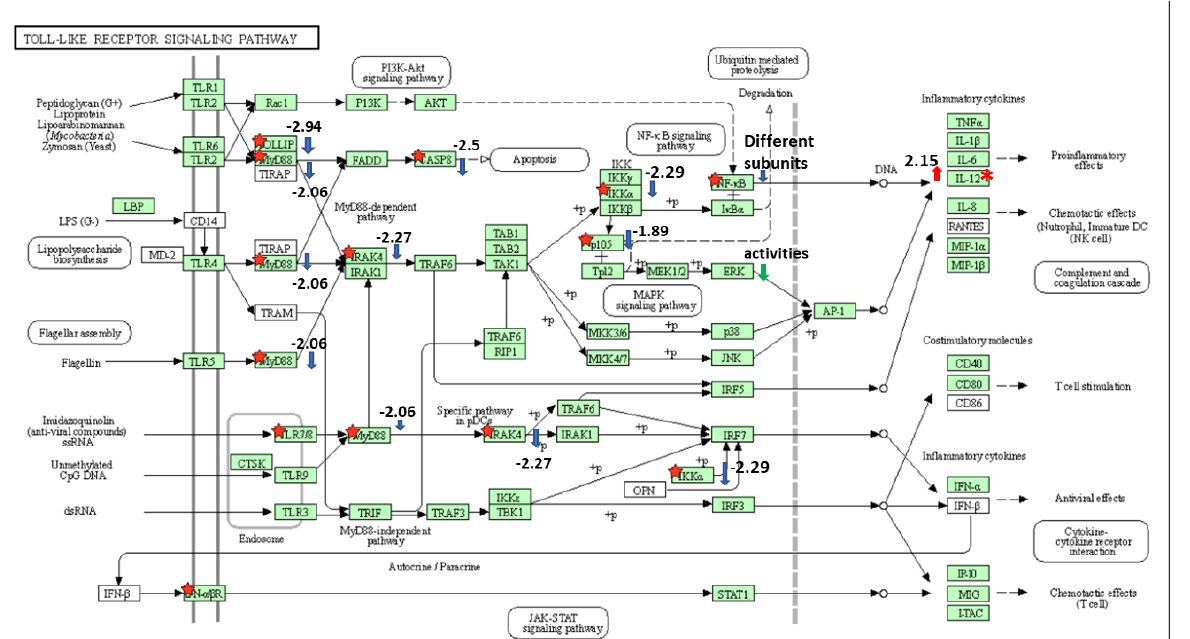
Figure 3. Toll-like receptor signaling pathway. The KEGG pathway enrichment analysis was per- formed by DAVID. Genes that differently expressed in HKDM- ∆EseN mutant compared to HKDM infected by WT indicated by red star and are significant ( p < 0.05 and q < 0.05). Red arrow indicates up-regulation. Blue arrow indicates downregulation. Numbers indicate log2 fold change in HKDM- ∆EseN vs . HKDM-WT.